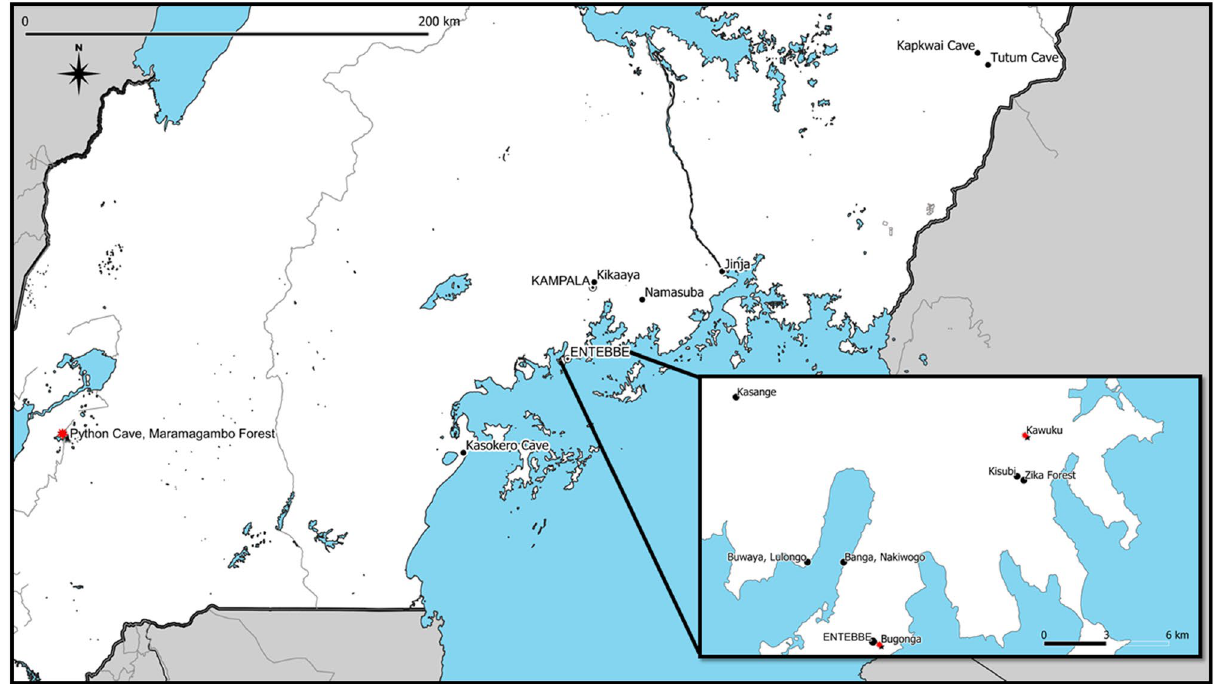
Figure 1. Map of Uganda, with trap sites indicated by black circles and positive sites indicated by red stars (Python Cave, Maramagambo Forest: Egyptian rousette bat, 2009 (n = 1); Kawuku: Ethiopian epauletted fruit bat, 2013 (n = 1); Bugonga: African straw-colored fruit bat, 2011 (n = 2)). Map was created using QGIS 3.4.2 (www. qgis. org).